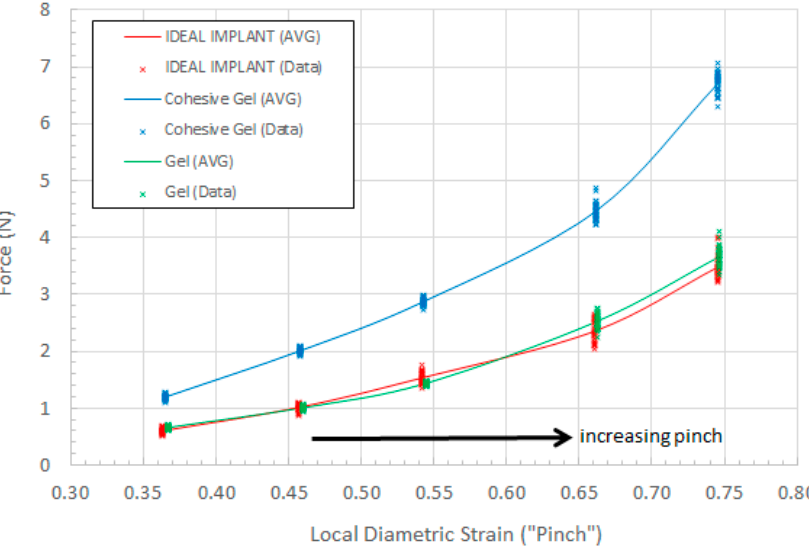
Figure 18. Pinch Force as a Function of Local Diametric Strain.